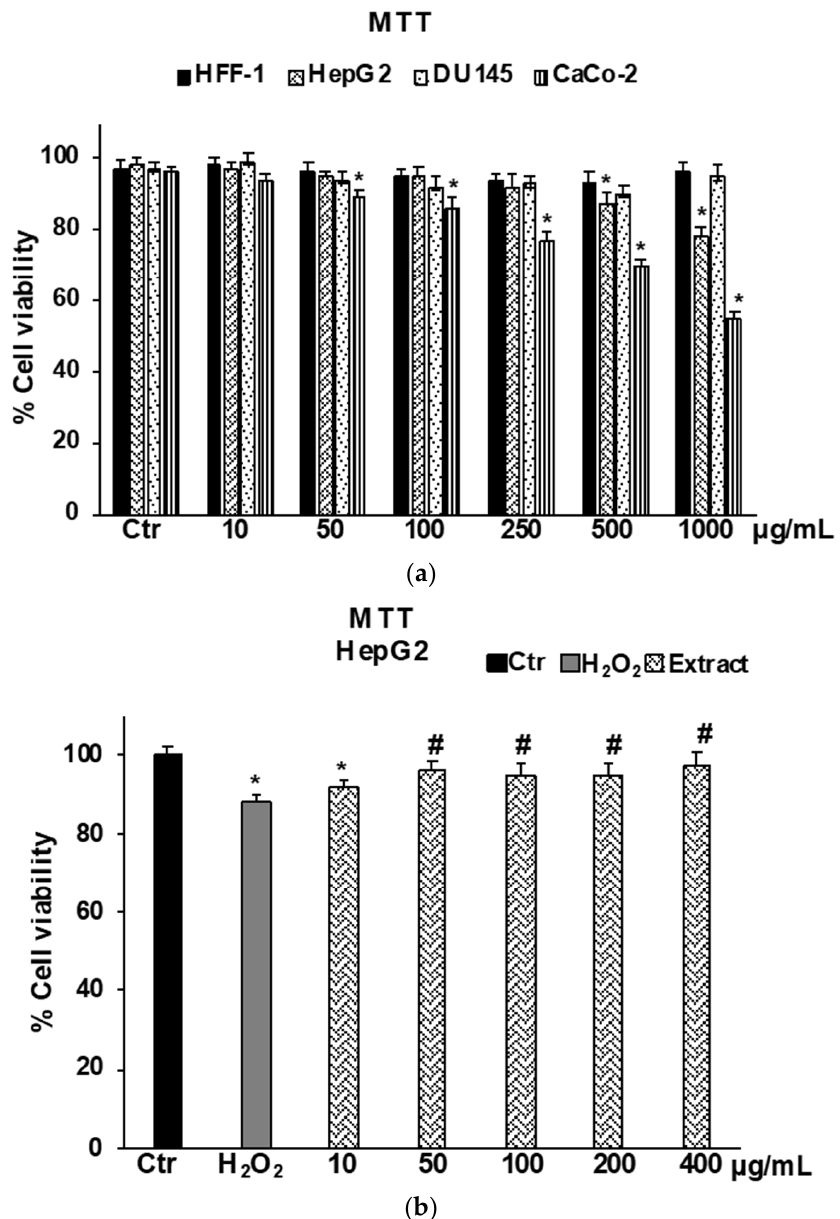
Figure 3. Cell viability in HFF-1, HepG2, DU145, and CaCo-2 cells untreated (Ctr), and treated with Brassica raimondoi extract for 24 h ( a ). Cell viability in HepG2 cells untreated (Ctr), treated for 2 h with H 2 O 2 200 μM (H 2 O 2 ), and pre-treated with the extract (10–50–100–200–400 μg/mL) followed by H 2 O 2 treatment (200 μM) for 2 h ( b ). Values are the mean ± S.D. of five experiments in triplicate. Confidence intervals calculated by two-way ANOVA test: * Significant vs. untreated control cells: p < 0.001; # Significant vs. H 2 O 2 treated cells: p < 0.001.